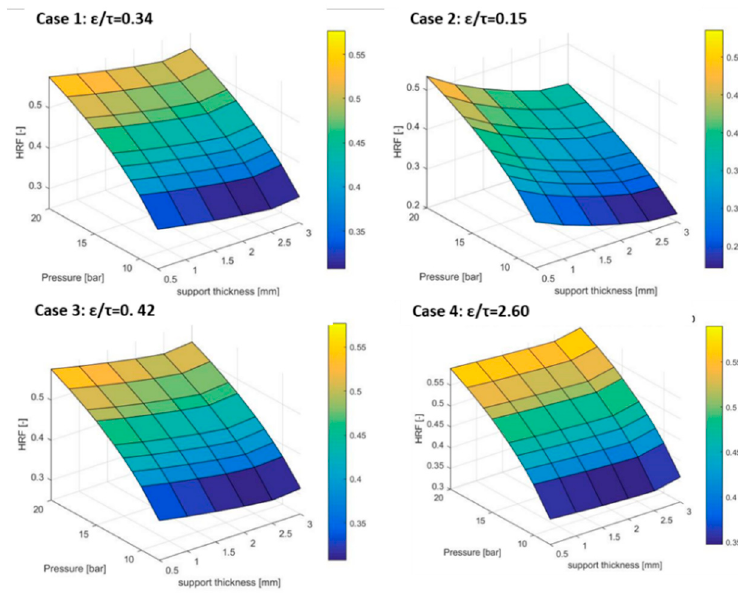
Figure 3. Pressure gradients comparison for the considered cases.